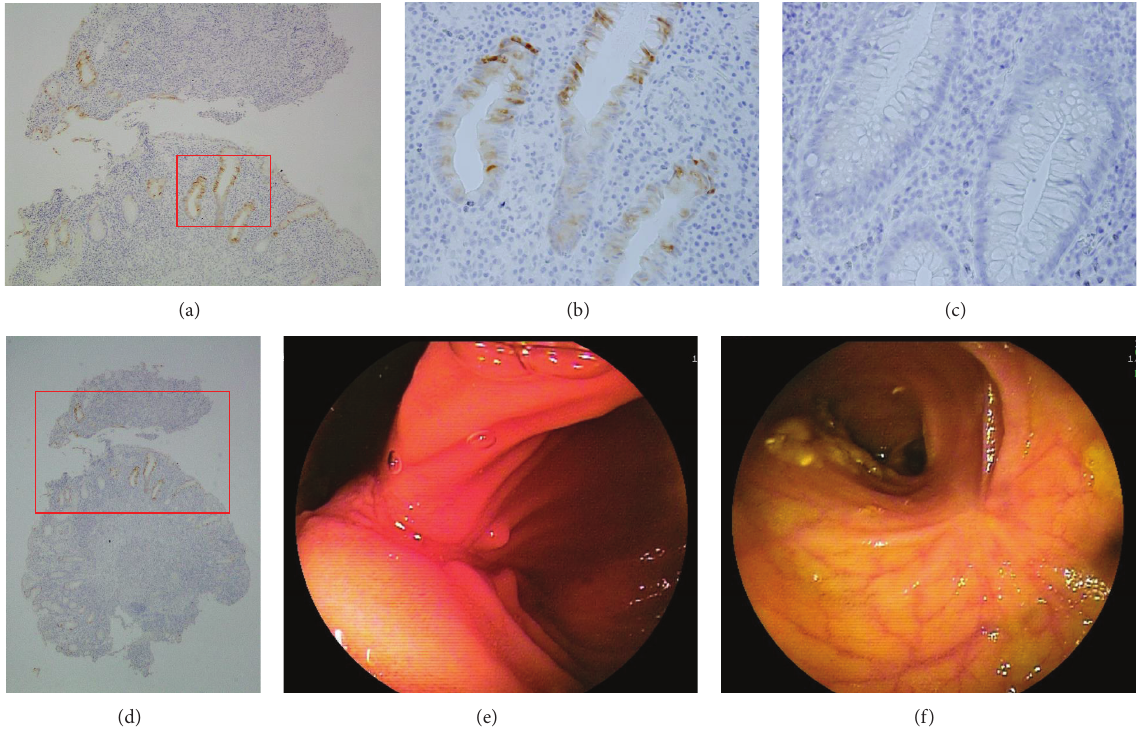
Figure 3: Ectopic MUC5AC expression is often positive in the cytoplasm of the mucous cells of the intestine in active CD (a, b, and d). Loss of MUC5AC expression is produced by adalimumab (ADA) in patients with remission stage (c). (a) × 100; (b) and (c) × 400; (d) × 40. Deep longitudinal ulceration was detected in the ileum by double balloon endoscopy (DBE) before ADA therapy (e) and the lesion showed mucosal healing after ADA therapy